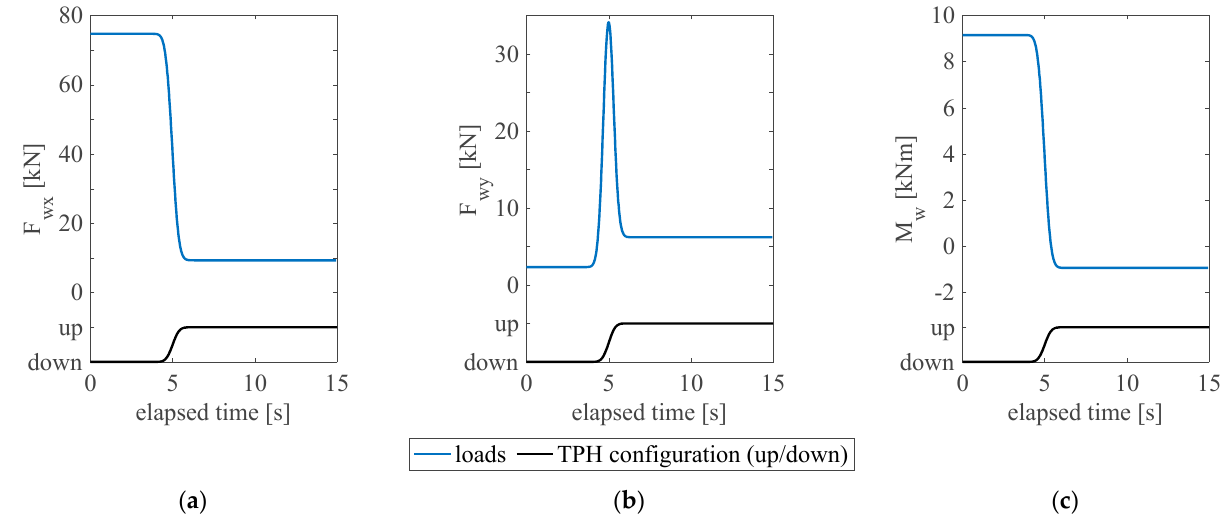
Figure 11. Soil–implement system of forces during the reference manoeuvre: ( a ) horizontal force (positive if rearward); ( b ) vertical force (positive if downward); and ( c ) moment of the resultant about the point 𝑃 (cid:3039)(cid:3028)(cid:3031) (positive if anti-clockwise).